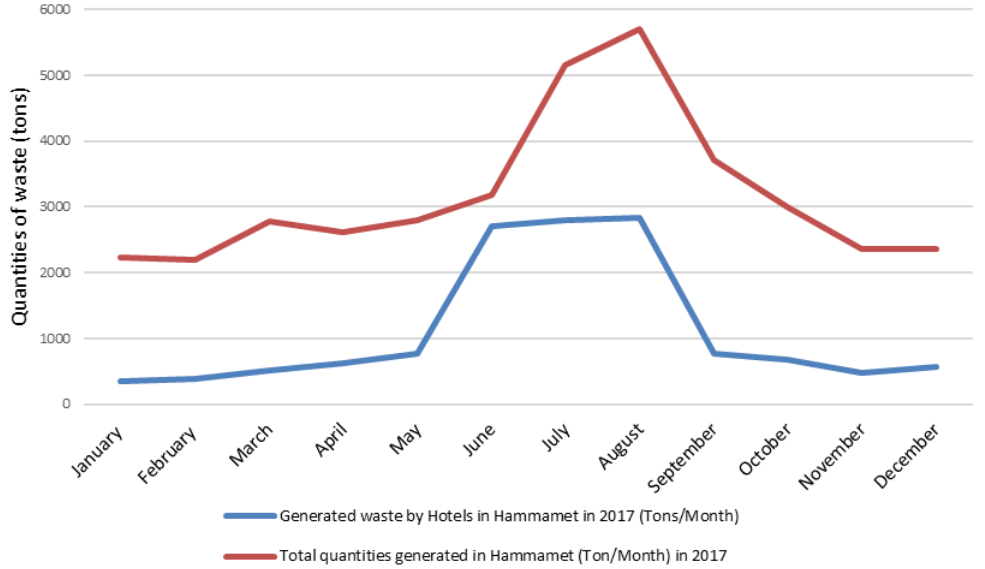
Figure 5. Comparison of SW generated in Hammamet by tourism and households in 2017 (Tons/Month).